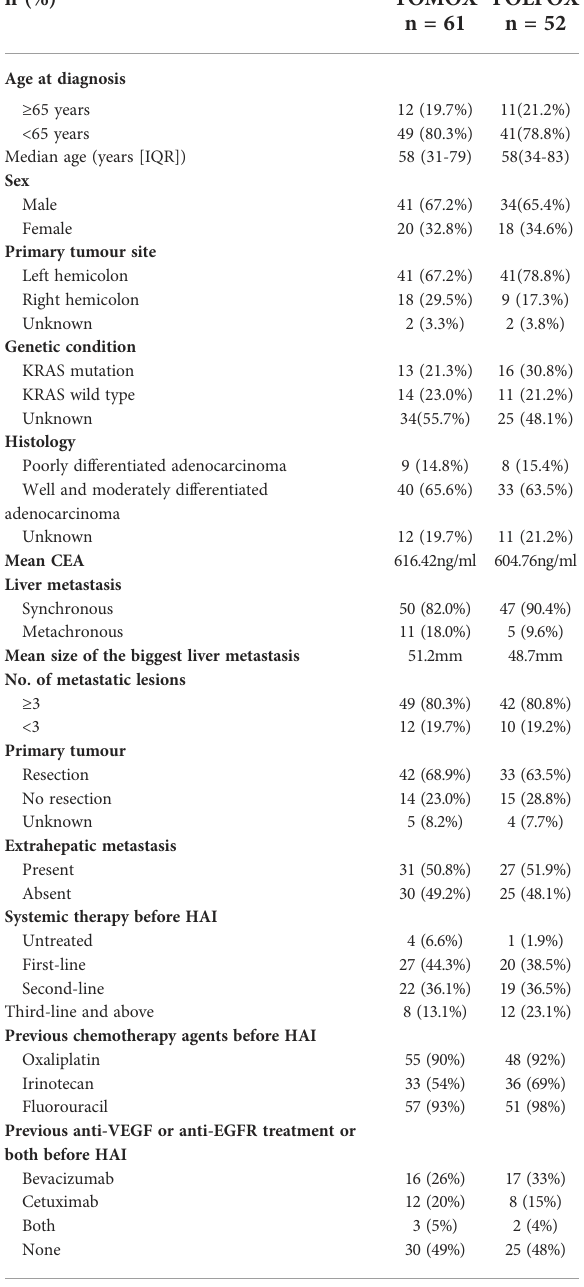
TABLE 1 Patient demographics and baseline